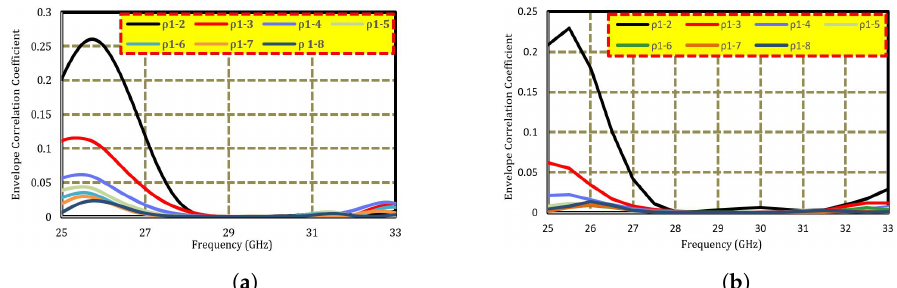
Figure 6. Envelope correlation coefficient of the proposed MIMO antenna using ( a ) S-parameters and ( b ) radiation patterns.